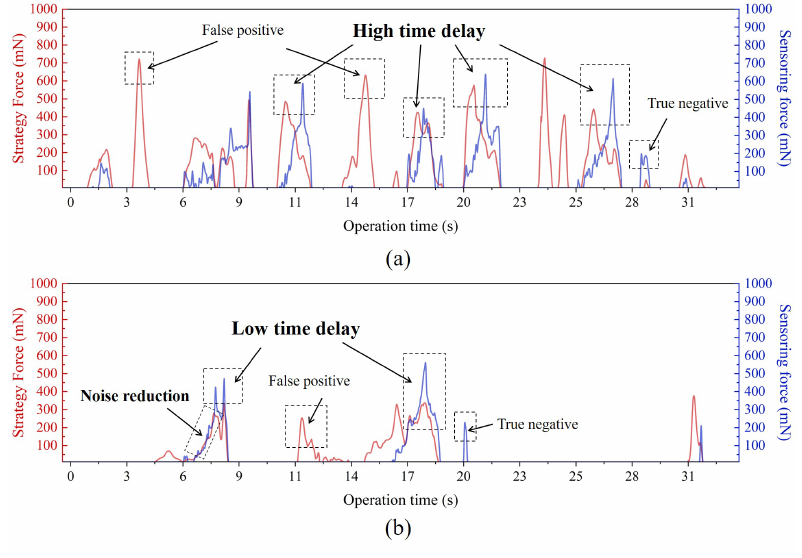
Figure 12. Comparison of feedback force. ( a ) Without GCCM in RF. ( b ) With GCCM in RG. Calculating the rotation time of the guidewire can also reflect the efficiency of the method. Therefore, a boxplot for the rotation time from five operators is drawn in Figure 13. HH is missing because the rotation could not be recorded. Among the remaining three cases, RG achieved the shortest average rotation operation time (6.52 s in invisible and 4.86 s in visible vascular operation). Compared with RF (8.56 s in invisible and 6.90 s in visible vascular operation), there was an improvement of approximately 23% to 29% using the GCCM method. These results show that the GCCM-strategy could improve the efficiency of the guidewire